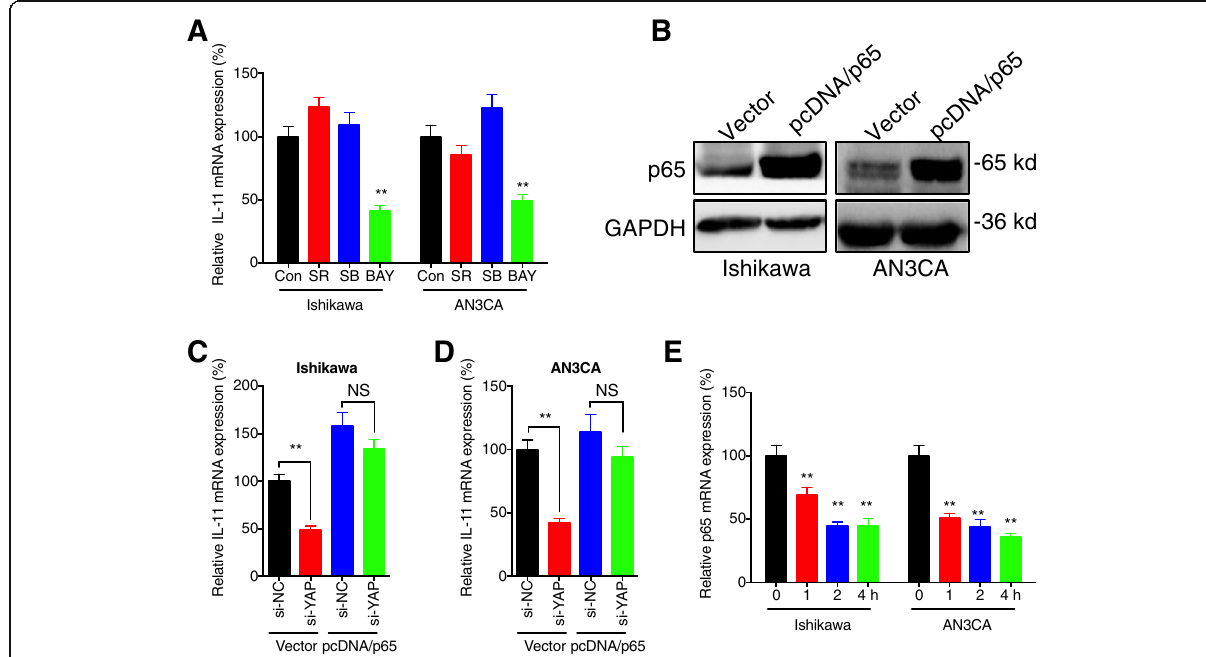
Fig. 6 NF- κ B is involved in YAP regulated transcription of IL-11 in EC cells . ( a ) Ishikawa or AN3CA cells were treated with or without inhibitor of AP-1 (SR 11302, 10 μ M), SMAD2/3 (SB431542, 10 μ M), and NF- κ B (BAY 11 – 7082, 10 μ M), respectively, for 24 h, the mRNA of IL-11 was measured by use of qRT-PCR; ( b ) Cells were transfected with vector control or pcDNA/p65 for 24 h, the expression of p65 was measured by western blot analysis; Ishikawa ( c ) or AN3CA ( d ) cells were pre-transfected with si-NC or si-YAP for 6 h, and then further transfected with vector control or pcDNA/p65 for 24 h; ( e ) Cells were treated with VP for the indicated times, the mRNA of p65 was measured by use of qRT-PCR. Data are presented as means ± SD of three independent experiments. ** p < 0.01 compared with